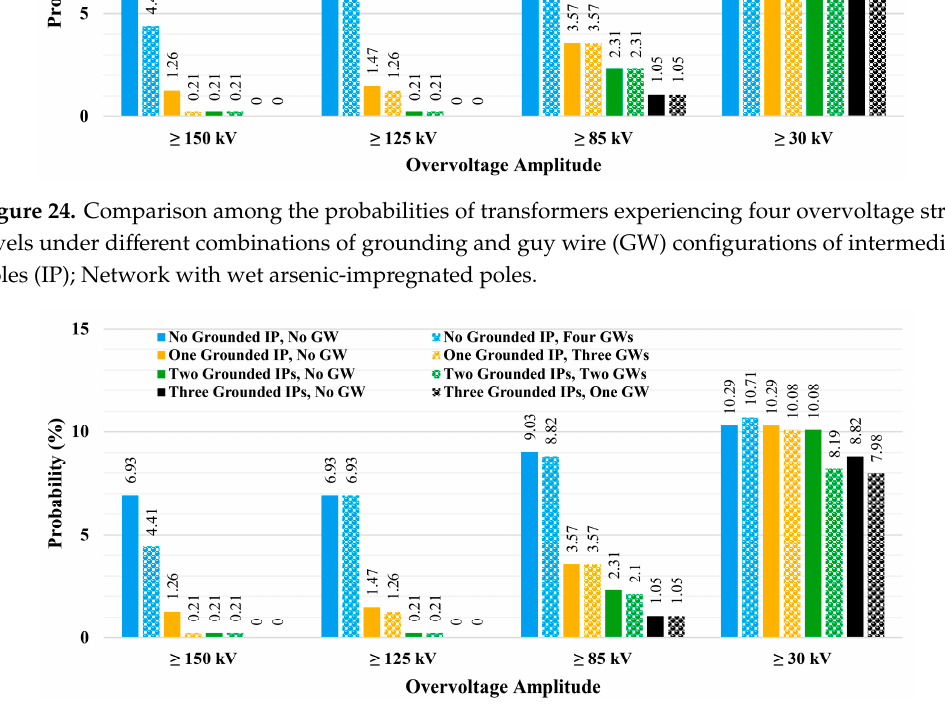
Figure 25. Comparison among the probabilities of transformers experiencing four overvoltage stress levels under different combinations of grounding and guy wire (GW) configurations of intermediate poles (IP); Network with dry poles.